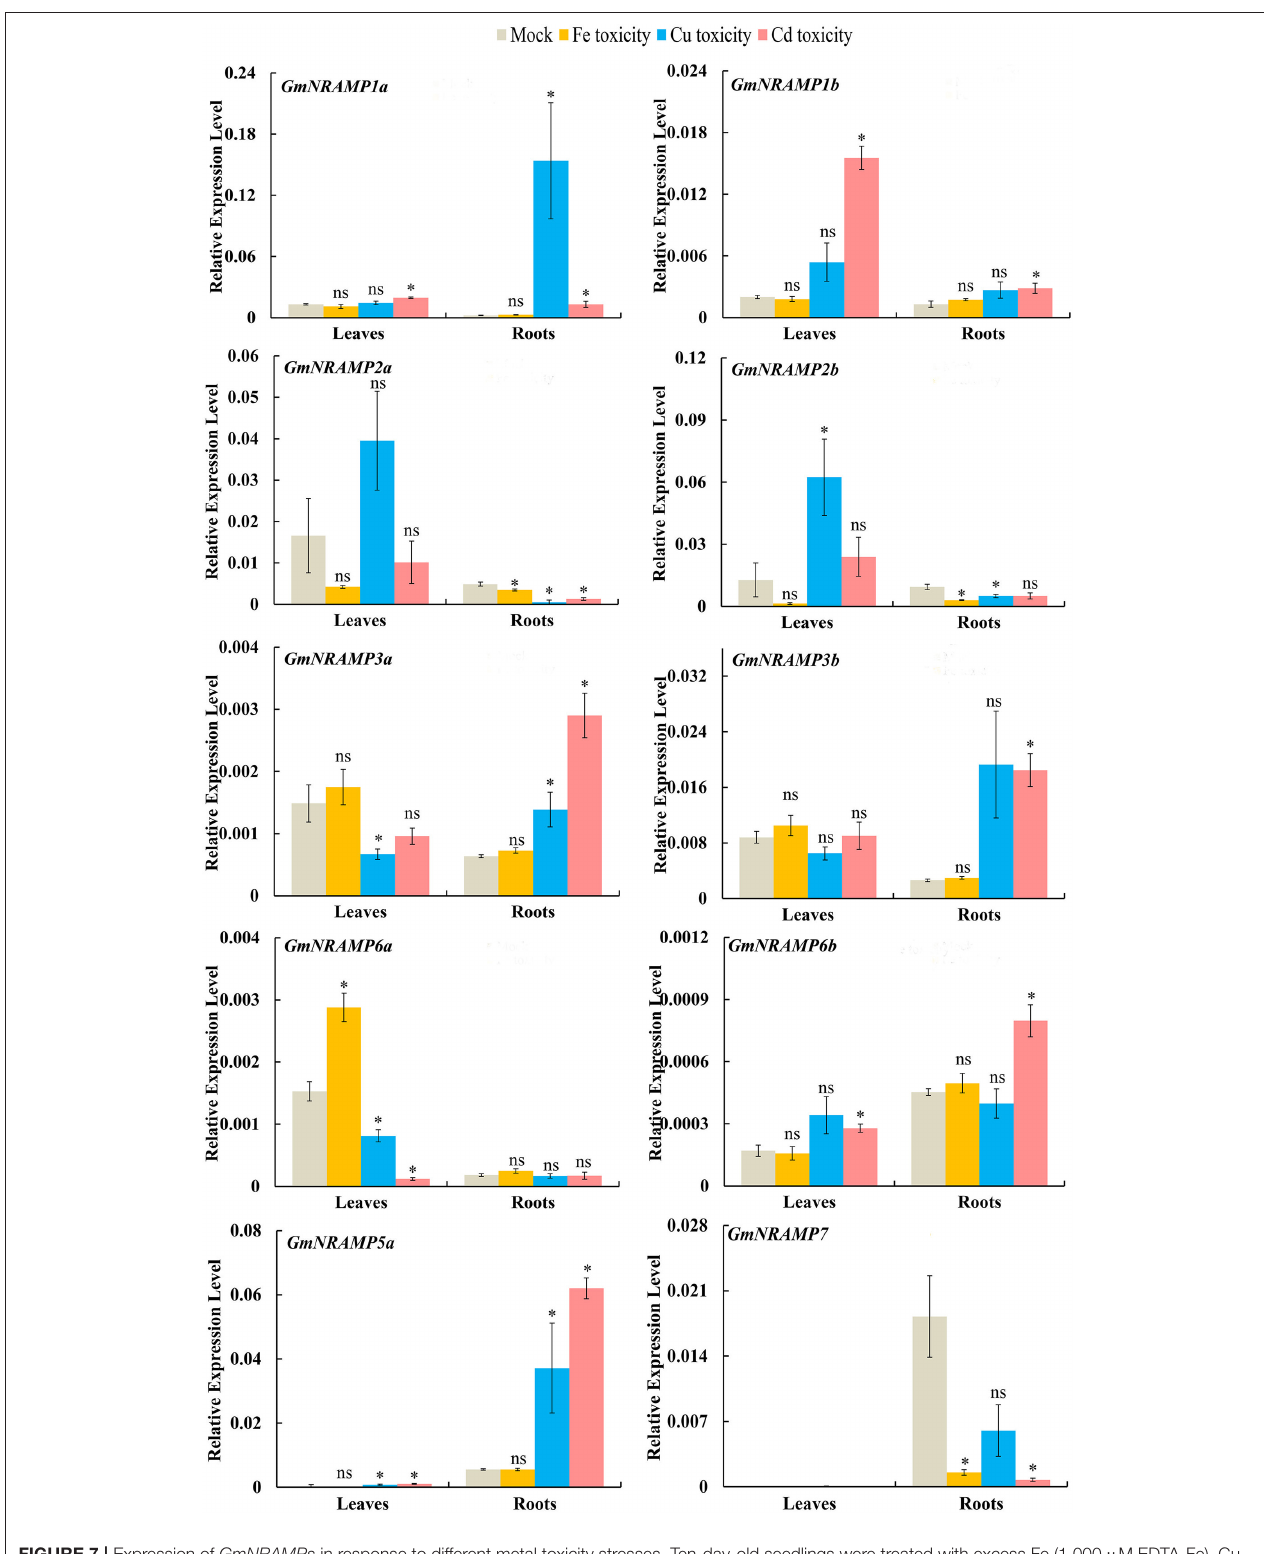
FIGURE 7 | Expression of GmNRAMPs in response to different metal toxicity stresses. Ten-day-old seedlings were treated with excess Fe (1,000 µ M EDTA-Fe), Cu (200 µ M CuSO 4 · 5H 2 O), and Cd (100 µ M CdCl 2 ) treatments for 24 h. Each bar is the mean of four biological replicates with standard error. “*” indicates effects of toxicity treatments relative to controls in one-way analysis of variance, * P < 0.05, ns: not